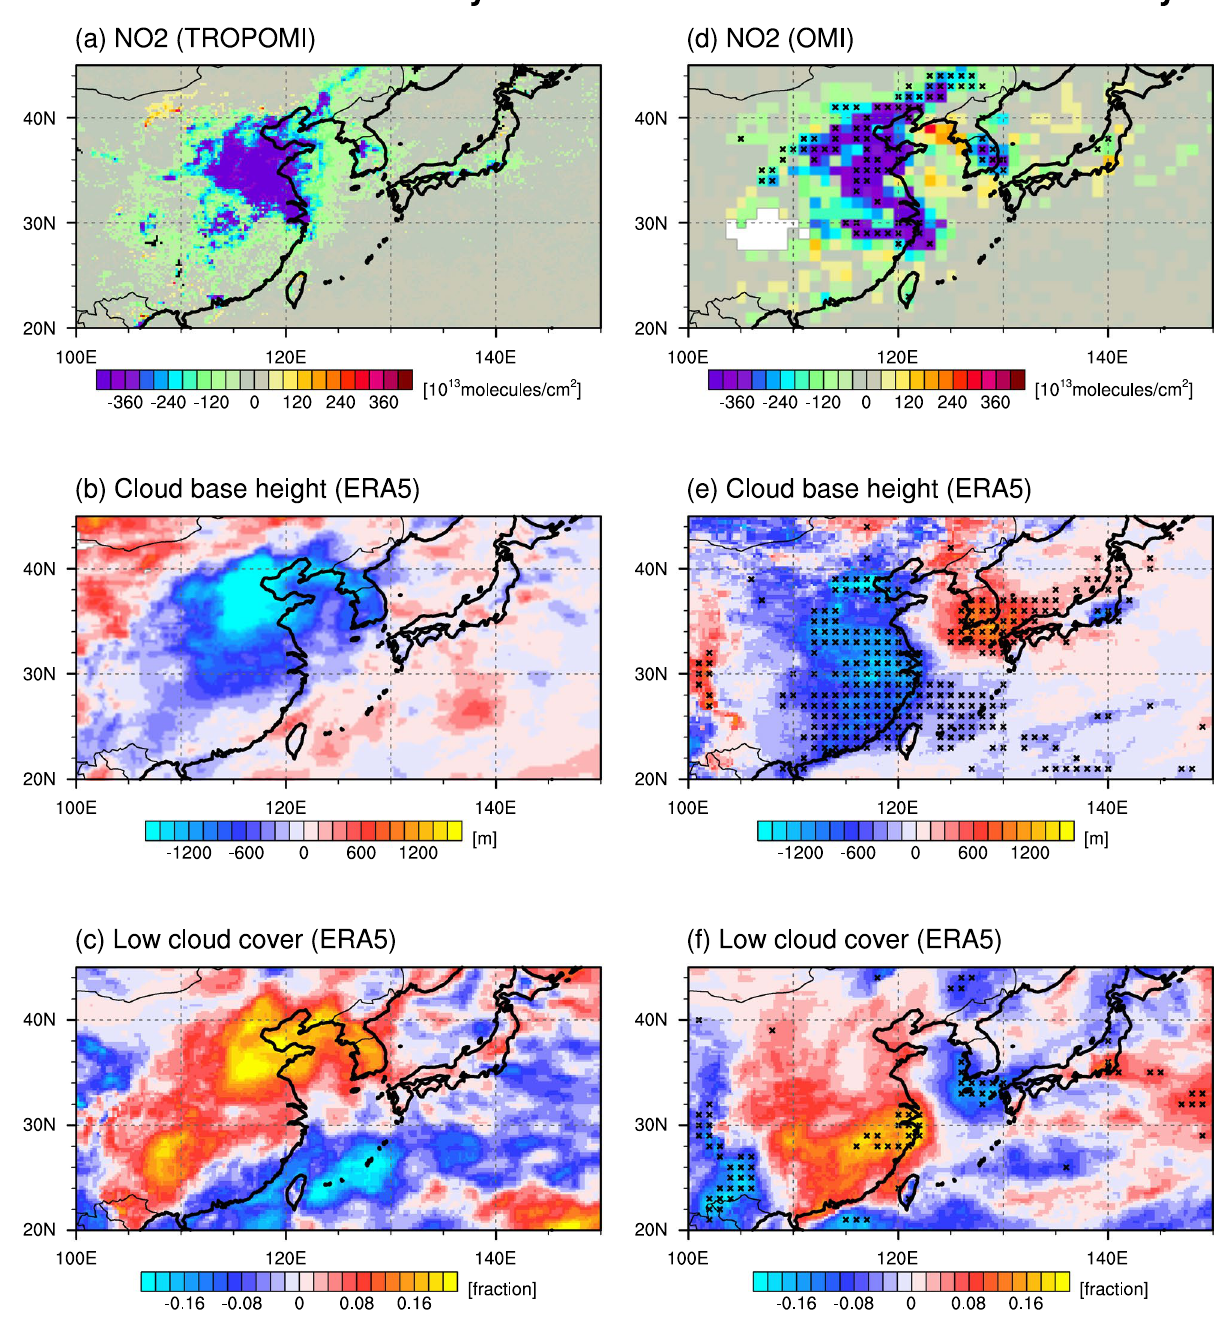
Figure 1. Anomalies of NO 2, cloud base height, and low cloud cover. ( a ) Difference between monthly NO 2 concentration in February 2020 and the February composite over years 2018–2019 from TROPOMI 43 . ( b ) Difference between monthly cloud base height in February 2020 and the February composite over years 2016– 2019 from ERA5 44 . ( c ) Same as in ( b ), but for low cloud cover. ( d ) Composite mean difference between OMI NO 2 concentration 45 for the week including Chinese New Year’s day and the previous week over years 2011– 2020. ( e ) Same as in ( d ), but for cloud base height from ERA5. ( f ) Same as in ( d ), but for low cloud cover from ERA5. In ( d – f ), black crosses represent grid points where the composite mean difference is significant above the 90% confidence level. The figure was generated using NCAR Command Language Version 6.5.0 (http:// dx. doi. org/ 10. 5065/ D6WD3